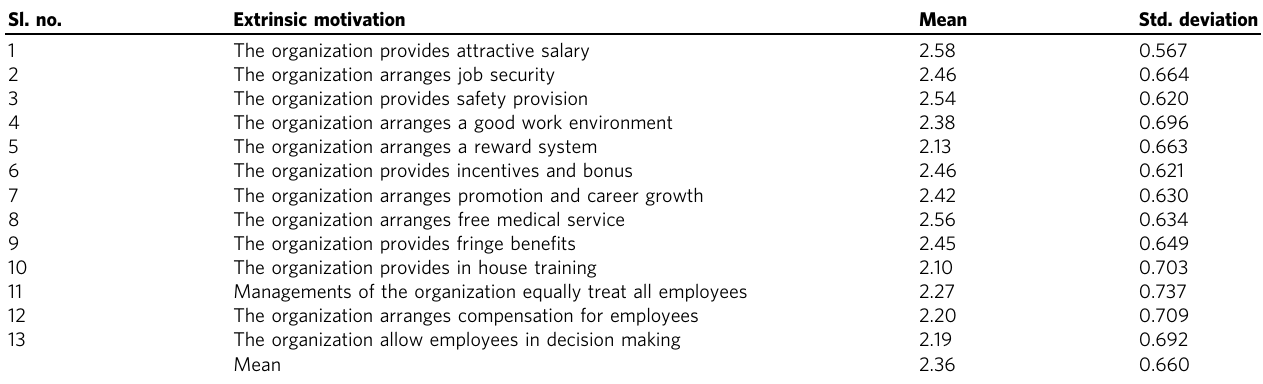
Table 2 Respondents view of extrinsic motivation. Sl. no.